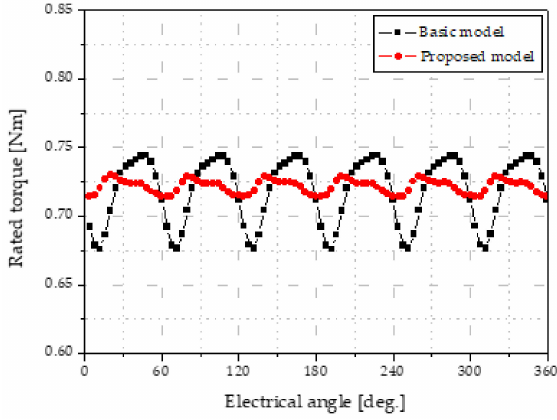
Figure 13. Torque waveform at rated load (at 4020